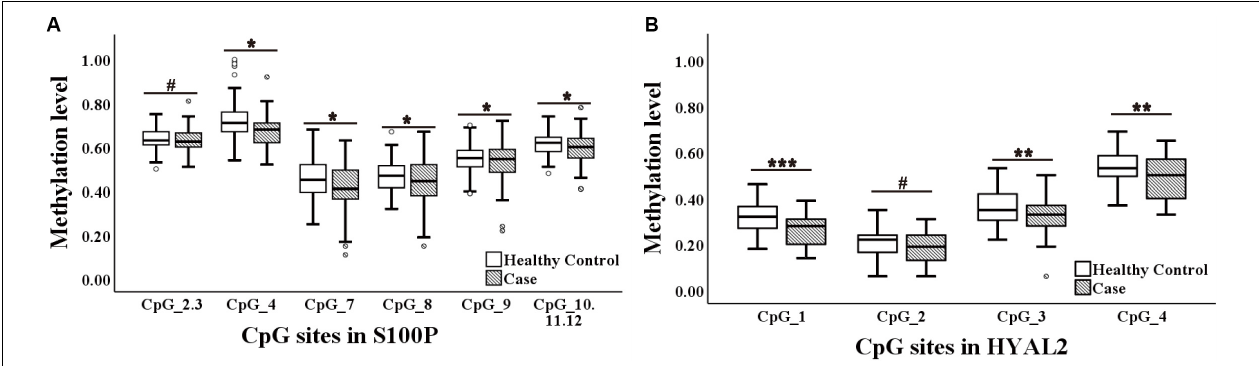
FIGURE 2 | Methylation levels of CpG sites in S100 calcium-binding protein P gene ( S100P ) and hyaluronoglucosaminidase 2 gene ( HYAL2 ) in sporadic breast cancer (BC) cases and controls in Study II measured by MassARRAY. (A) Box plot shows the distribution of methylation levels of all nine measured CpG sites in S100P . (B) Box plot shows the distribution of methylation levels of all four measured CpG sites in HYAL2 . The p -values were calculated by logistic regression adjusted for age and batches of measurement; # p > 0.05, * p ≤ 0.05, ** p ≤ 0.01, *** p ≤